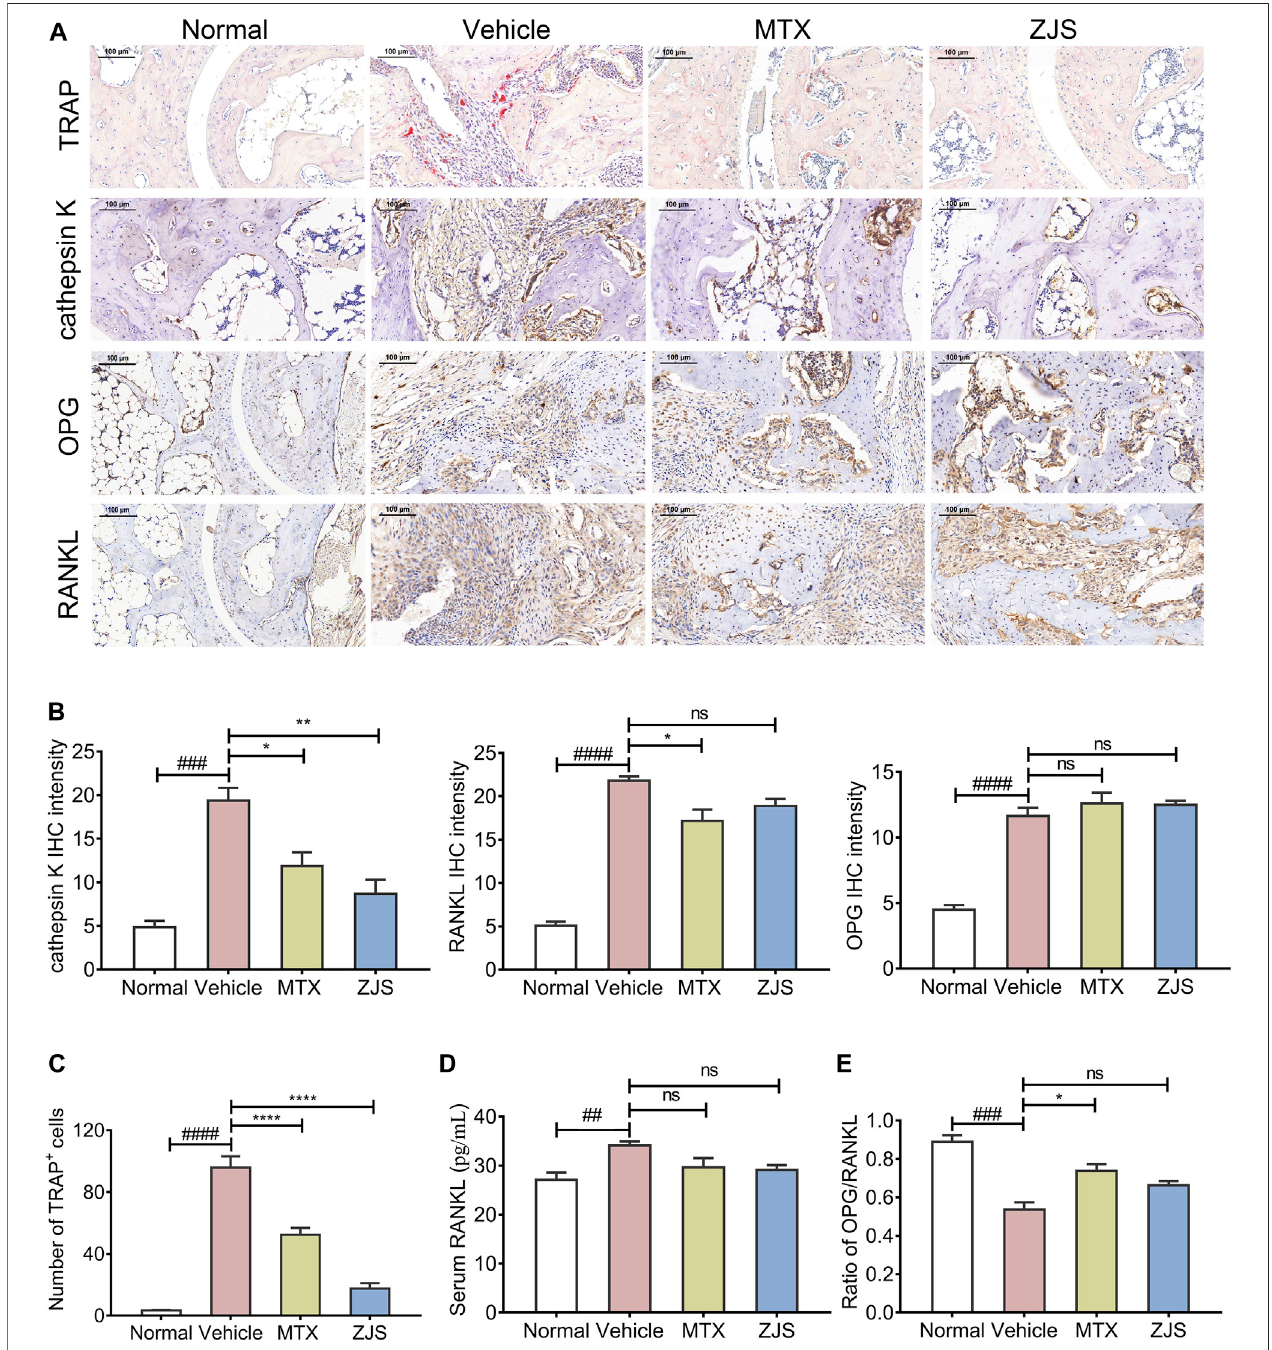
FIGURE 4 | ZJS decreased the number of osteoclasts and the expression of osteoclast-related proteins in the ankle joints of CIA mice. (A) Representative immunohistochemical staining images of TRAP, cathepsin K, OPG, and RANKL in the ankle joints of mice in the indicated groups (scales bars (cid:1) 100 μ m). (B) The quanti fi cation of cathepsin K, RANKL, and OPG expression in the ankle joints of mice in the indicated groups ( n (cid:1) 3). (C) The number of TRAP-positive cells in the ankle jointsintheindicatedgroups( n (cid:1) 5). (D) ThecontentofRANKLintheserumofmiceintheindicatedgroups( n (cid:1) 5). (E) RatiooftheIHCintensityofOPGandRANKL in the ankle joints in the indicated groups ( n (cid:1) 3). Values are presented as the mean ± SEM. ns: no signi fi cance. ## p < 0.01, ### p < 0.005, #### p < 0.001, compared with the normal group. * p < 0.05, ** p < 0.01, **** p < 0.001, compared with the vehicle group (One-way ANOVA test).